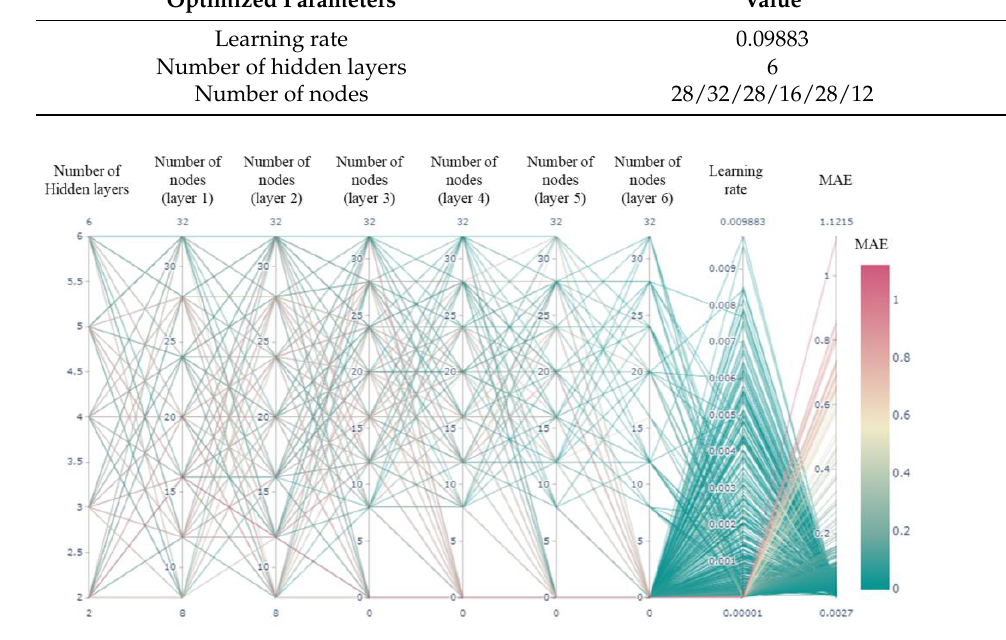
Figure 10. Hyperparameter tuning results. Table 5. Neural network prediction model performance, compared with MLR results.